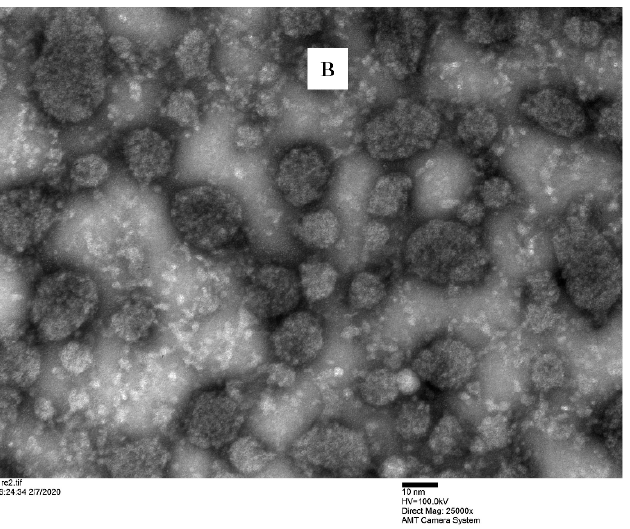
Figure 6. Microscopic observation of F2/N2CyA-ASNg/ATF gelled formulations under TEM. ( A ) scale bar: 21 nm; ( B ) scale bar: 10 nm.